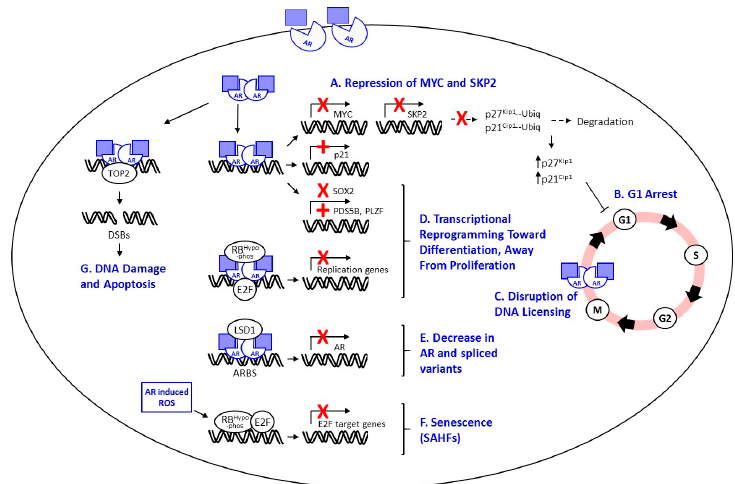
Figure 1. Potential mechanisms for repression of prostate cancer growth by high dose androgen. ( A )